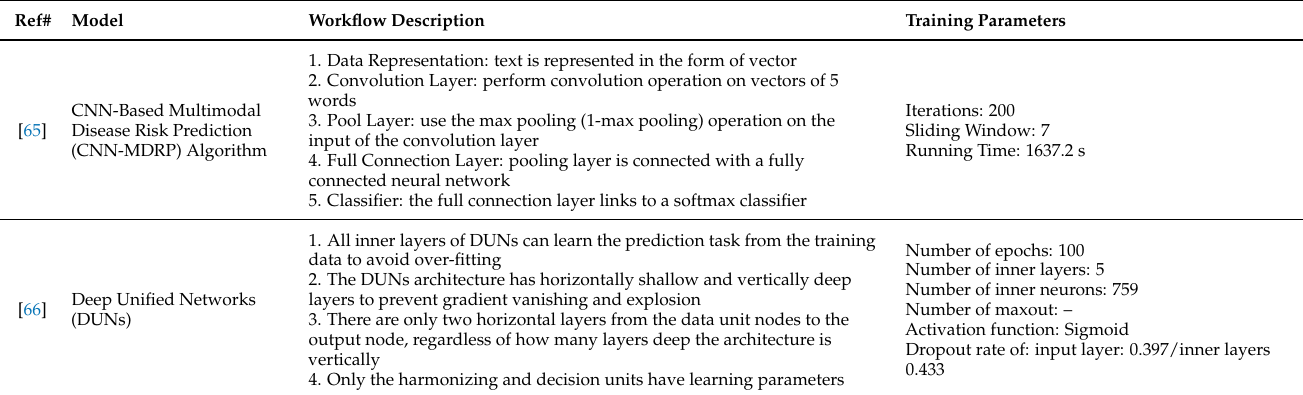
Table 6. Technical details for Multimodal models used in the prediction of